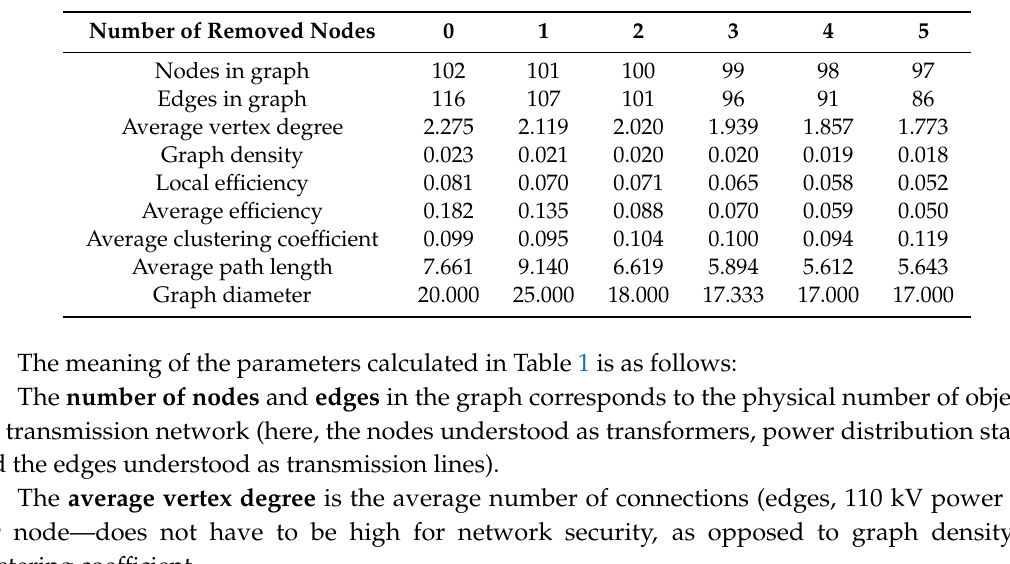
Table 1. Averaged data from the analysis of the modified